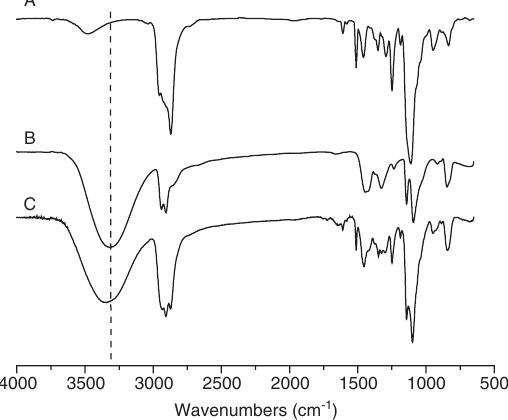
Figure 3: FTIR spectra of polyoxyethylene ether (A), untreated PVA fibers (B) and treated PVA fibers (C).